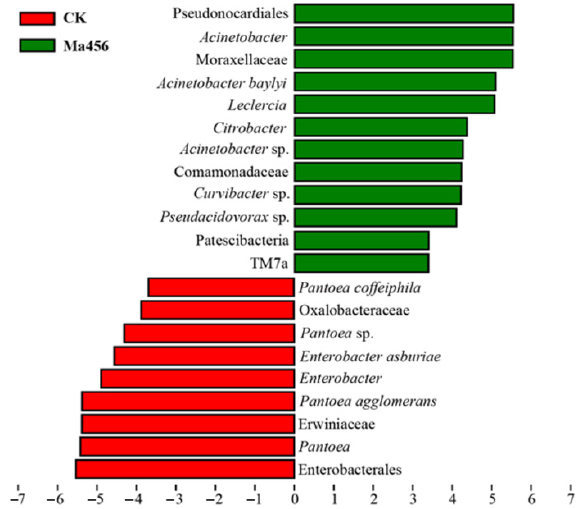
Figure 6. Different structures of gut bacteria between the fungus-infected (Ma456) and 0.02% Tween 80-treated (CK) groups identified by LEfSe analysis with linear discriminant analysis (LDA) scores of 3.0. Differentially abundant taxa are represented by histograms with LDA scores (red, CK; green, Ma456).